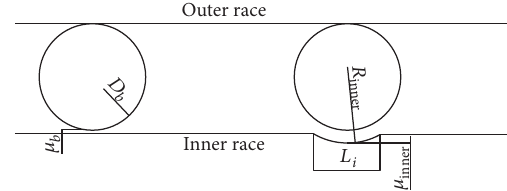
Figure 3: The Inner race defect of the ball.